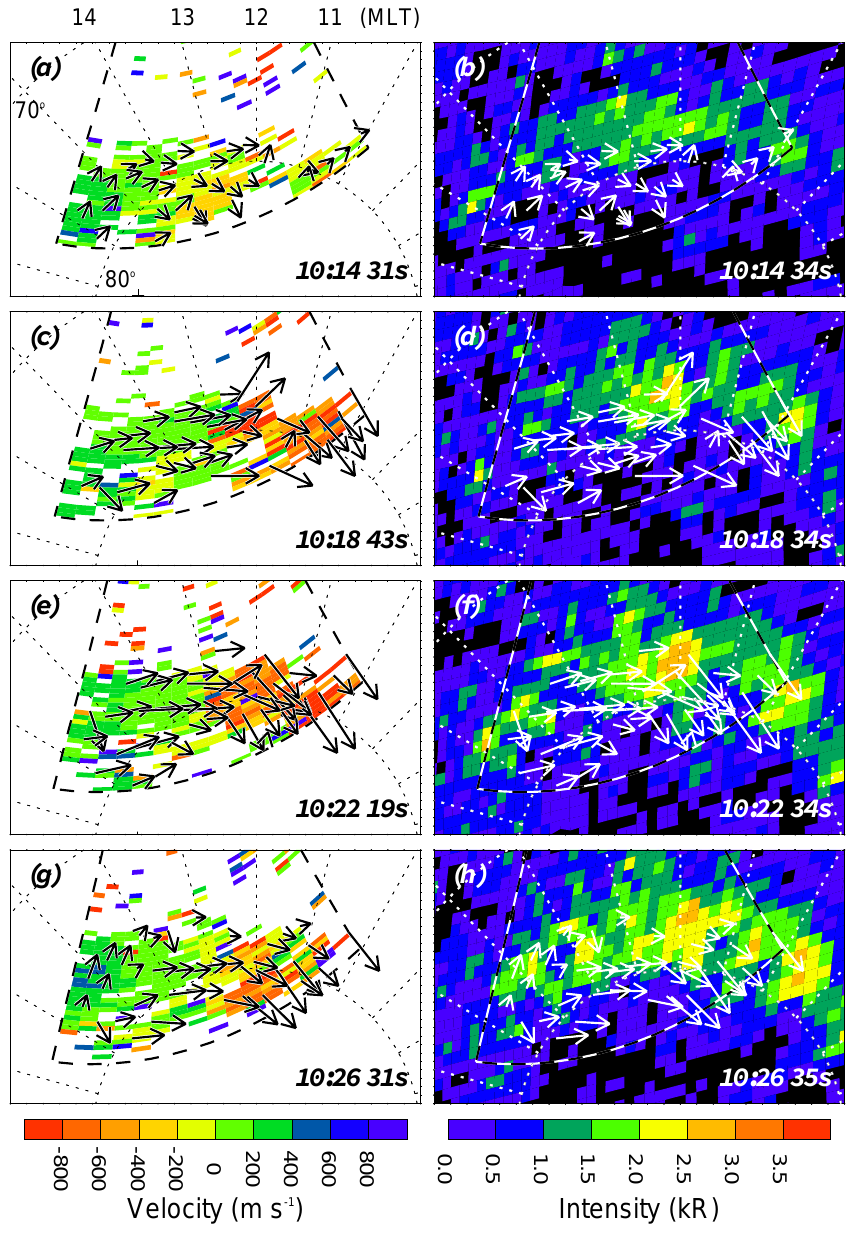
Fig. 2. Left column (a, c, e, g) CUT- LASS Hankasalmi line-of-sight veloc- ity scans for four 32 s scans during the interval 1014:31–1026:31 UT, in mag- netic local time-magnetic latitude coor- dinates, with noon at the top of the pan- els and dusk to the left. Beamswung velocity vector estimates are overlaid. Right column (b, d, f, h) The corre- sponding 32.5 s Polar VIS auroral im- ages. The beamswung vectors from panels (a, c, e, g) are overlaid for refer- ence, as is the outline of the Hankasalmi field-of-view. Each panel is marked with the radar scan/image start